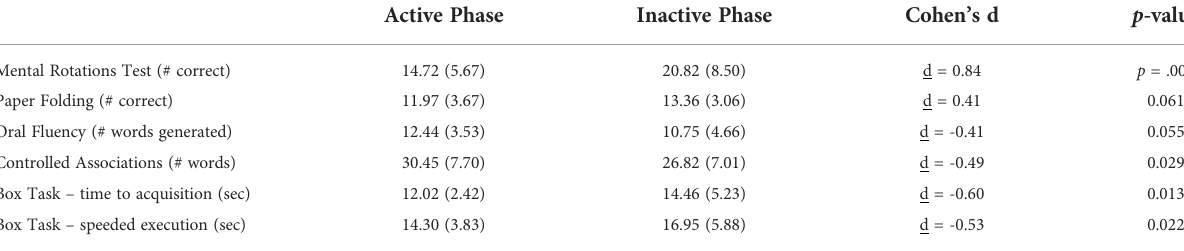
TABLE 1 Mean performance (SD) on the MRT and other cognitive tasks at the active and inactive phases of the contraceptive